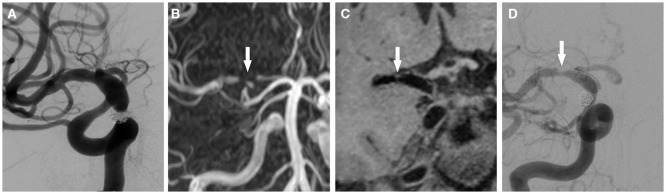
A 46 year-old man with a right posterior communicating artery aneurysm. (A) PED and coils was performed for it. (B) after 6 months, 3D-TOF MRA shows signal loss of the right proximal middle cerebral artery (false occlusion, arrow) and signal intensity of distal vessels. (C) the 3D T1-SPACE sequence demonstrates the moderate stenosis of the right origin segment of middle cerebral artery (arrow). (D) this result is consistent with DSA in evaluating of stent patency (arrow).